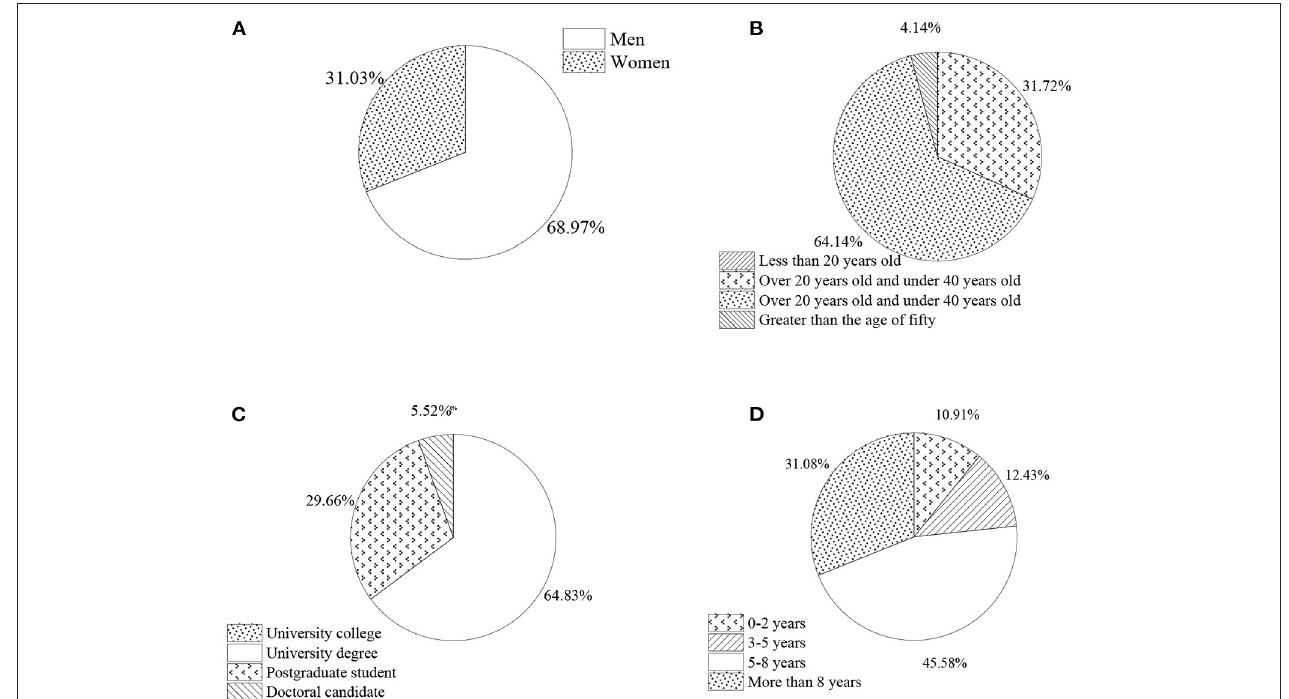
FIGURE 4 | Statistical results of personal characteristics of subjects. (A) Gender. (B) Age. (C) Education. (D) Entrepreneurship period.